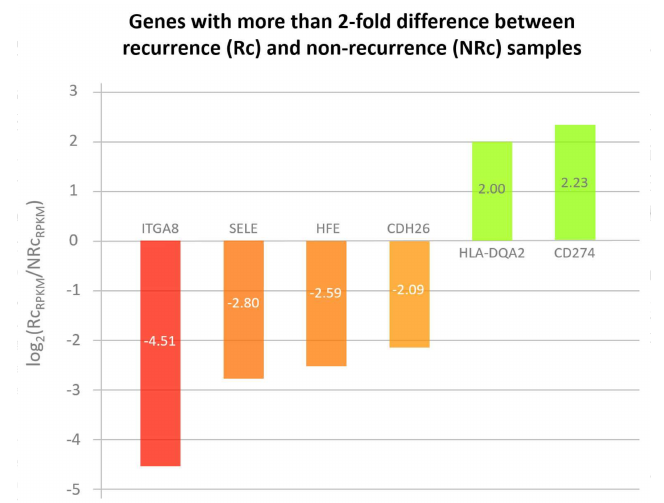
Figure 2. RNA-Seq result shows cell adhesion molecules that had more than two-fold gene expression level difference between recurrence and non-recurrence samples in acutely injured liver grafts. Six cell adhesion molecules with intragraft gene expression level difference of more than two-fold when recurrence samples were compared to non-recurrence ones. Four molecules ( ITGA8 , SELE , HFE , and CDH26 ) have been down-regulated in recurrence samples, whereas two molecules ( HLA-DQA2 and CD274 ) were found to have been